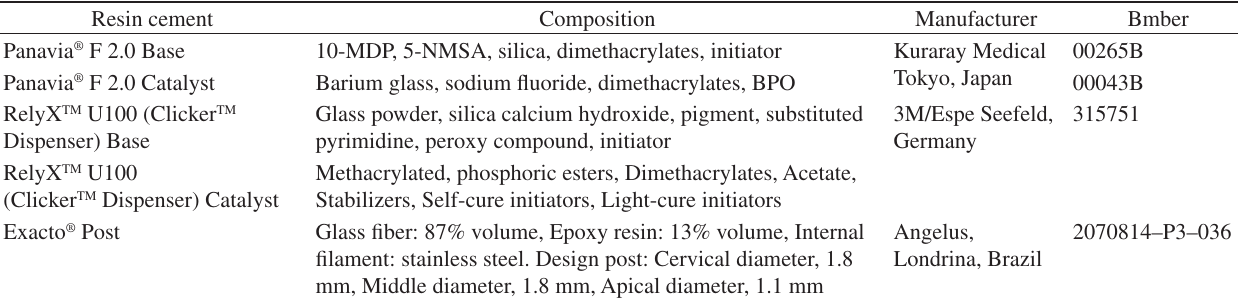
Table 1. Dental materials used in this study.